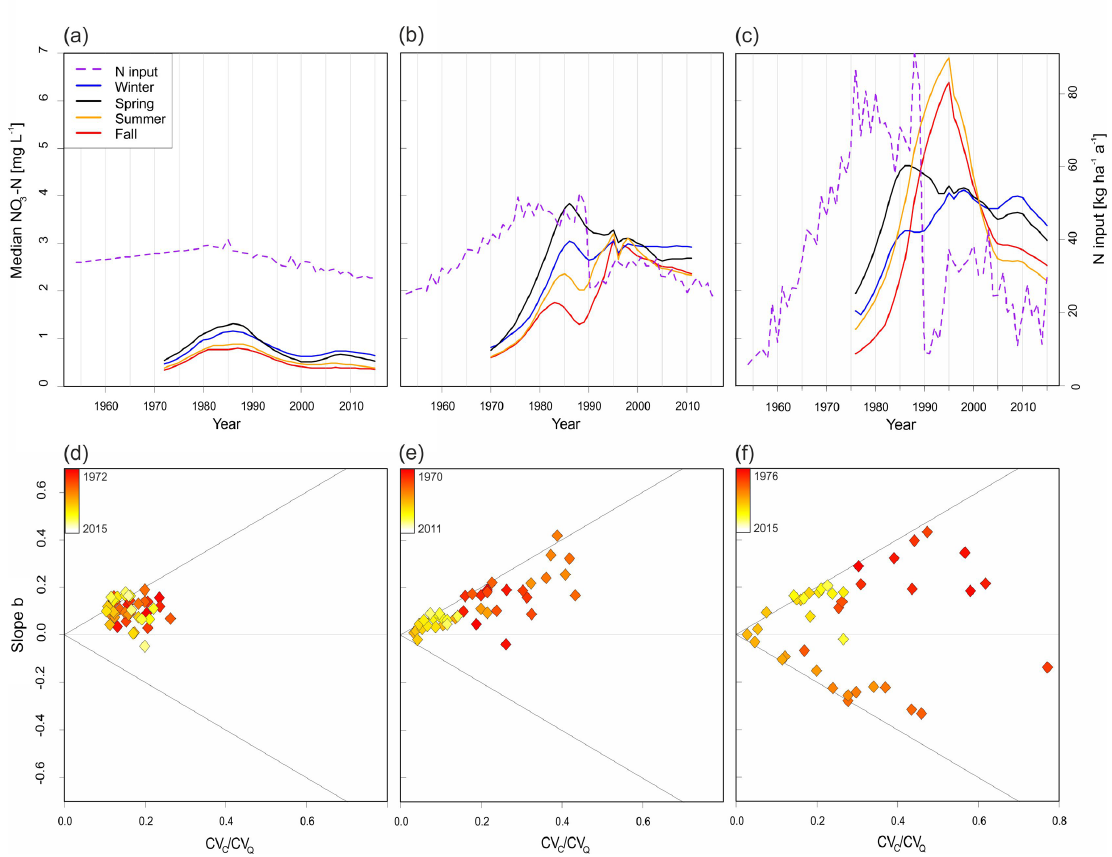
Figure 6. Annual N input (referring to the whole catchment, second y axis) to the catchment and measured median NO 3 –N concentrations in the stream (first y axis) over time at three different locations: upstream (a, d) , midstream (b, e) , downstream (c, f) . Lower panels show plots of slope b vs. CV C / CV Q for NO 3 –N for the three subcatchments following the classification scheme provided in Musolff et al. (2015). The x axis gives the coefficient of variation of concentrations ( C ) relative to the coefficient of variation of discharge ( Q ). The y axis gives the slope b of the linear ln( C )–ln( Q ) relationship. Colors indicate the temporal evolution from 1970 to 2015 along a gradient from red to